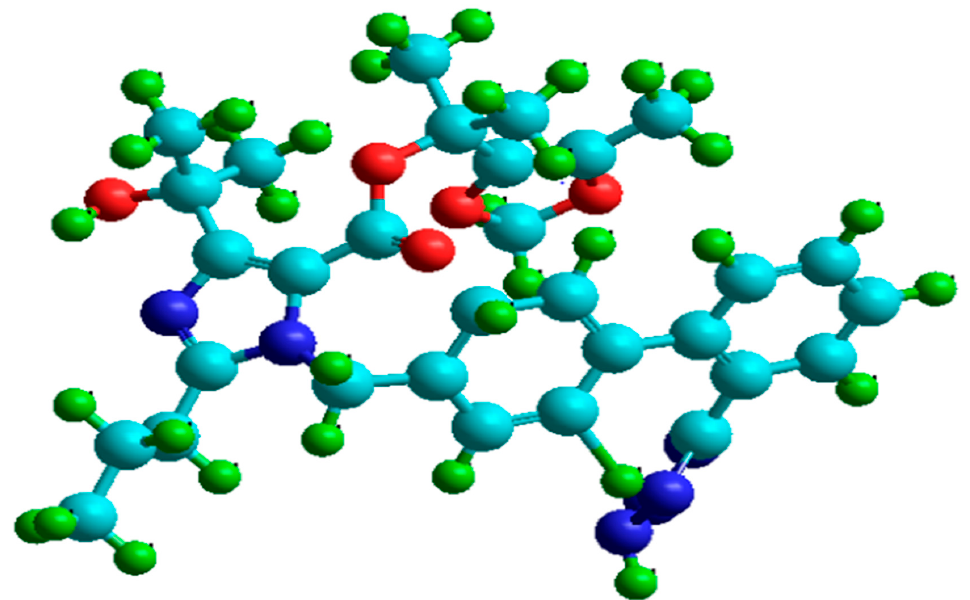
Figure 2. The optimized molecular structure of olmesartan.